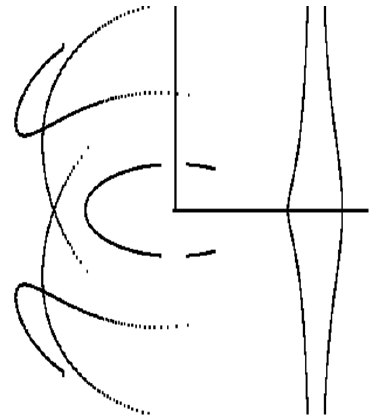
Figure 10. q = 1, KG = 120, and DK = 220.